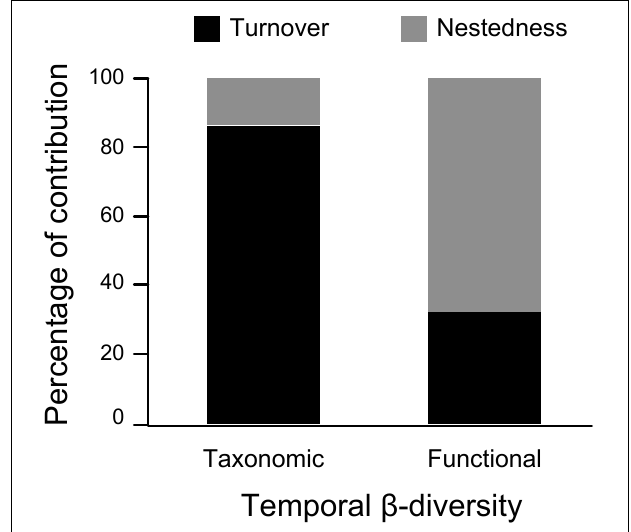
FIGURE 5 | Contribution of turnover and nestedness components to temporal taxonomic and functional β -diversity of ant metacommunity in Serra do Cipó, Minas Gerais State – Brazil. Data from 12 sampling periods between April 2011 and January 2014.